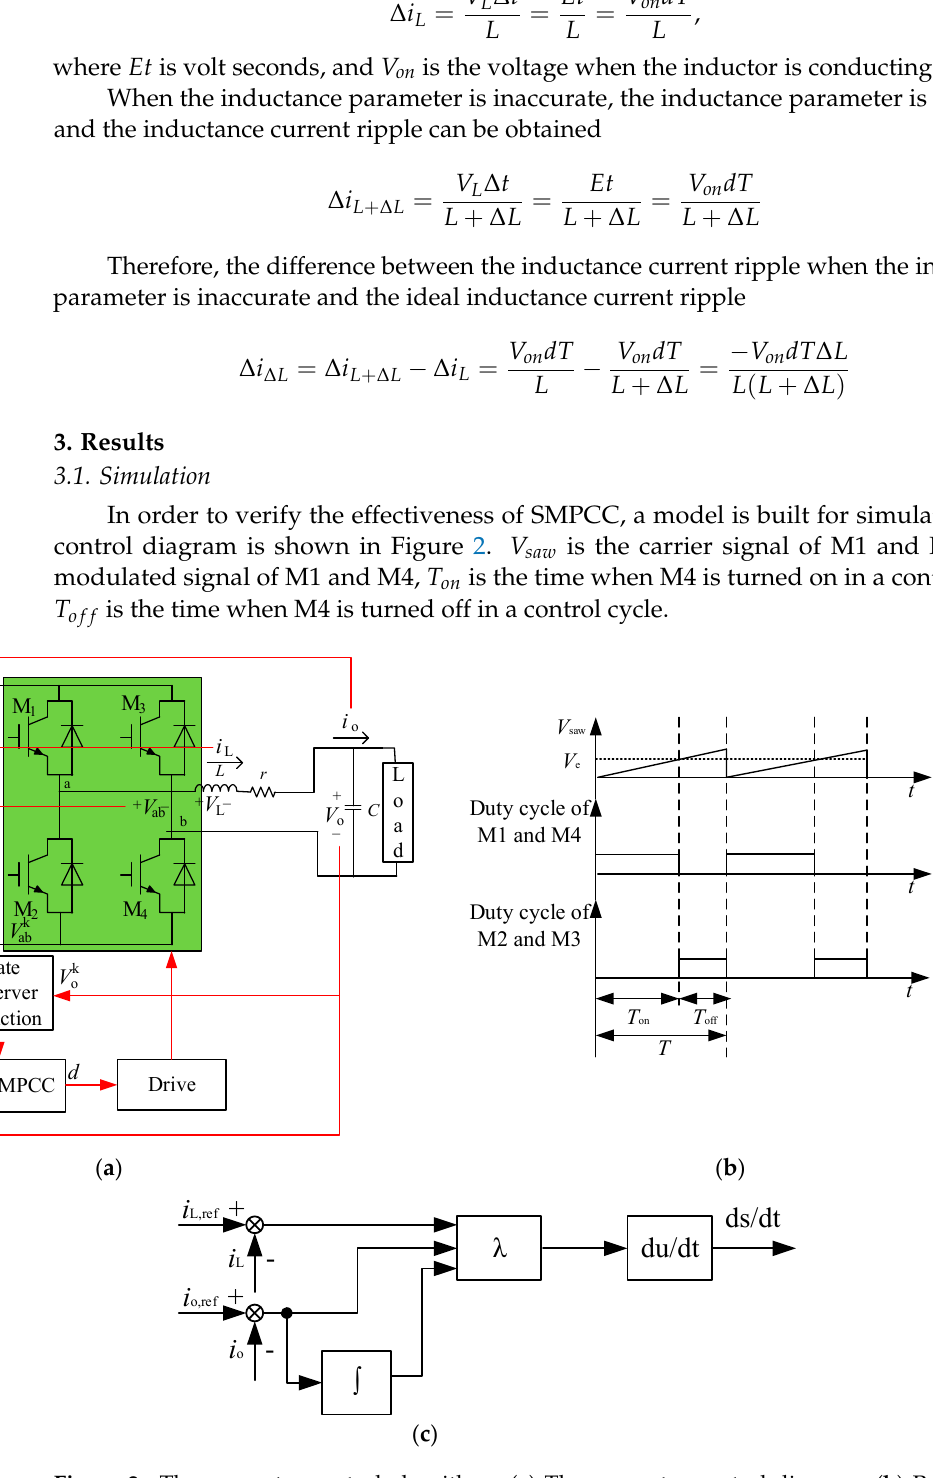
Figure 2. The converter control algorithm. ( a ) The converter control diagram; ( b ) Pulse width modulation (PWM) algorithm; ( c ) The detailed block diagram of the proposed sliding mode predictive current control (SMPCC).